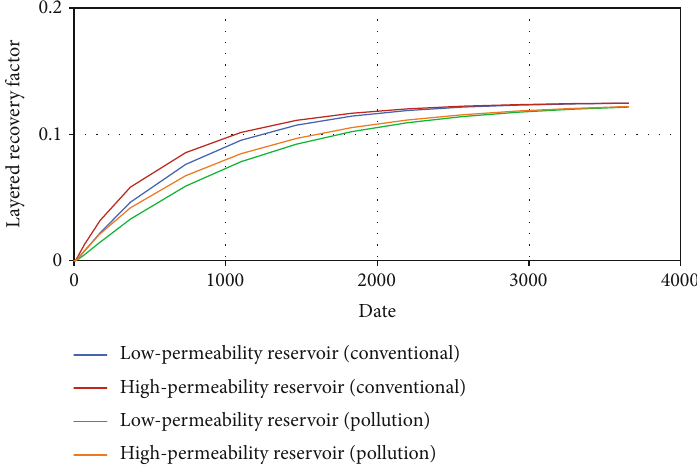
Figure 7: Recovery of a single well under di ff erent